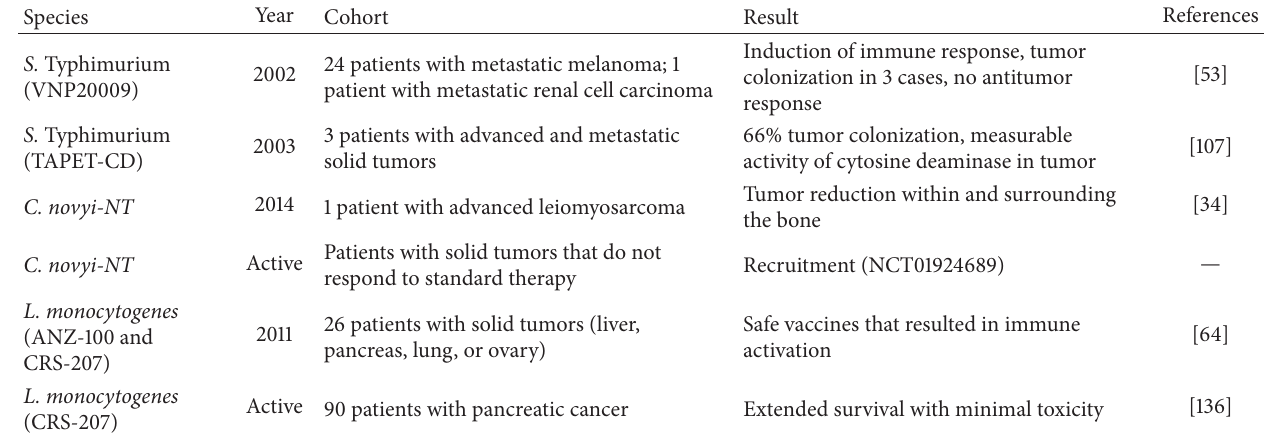
Table 2: Recent examples of clinical trials with bacteria mediated tumor therapy (BMTT) since 2002.